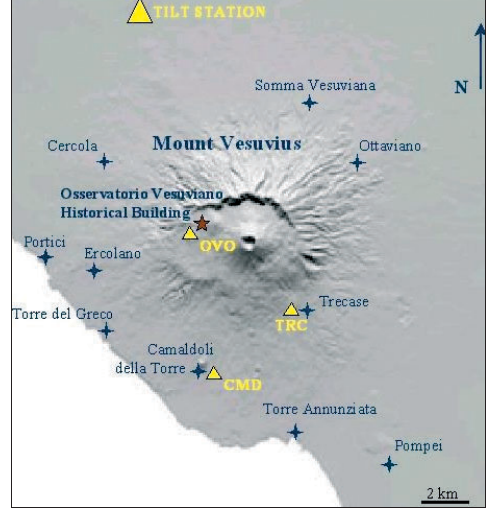
Fig. 6. OV Vesuvian tiltmeter